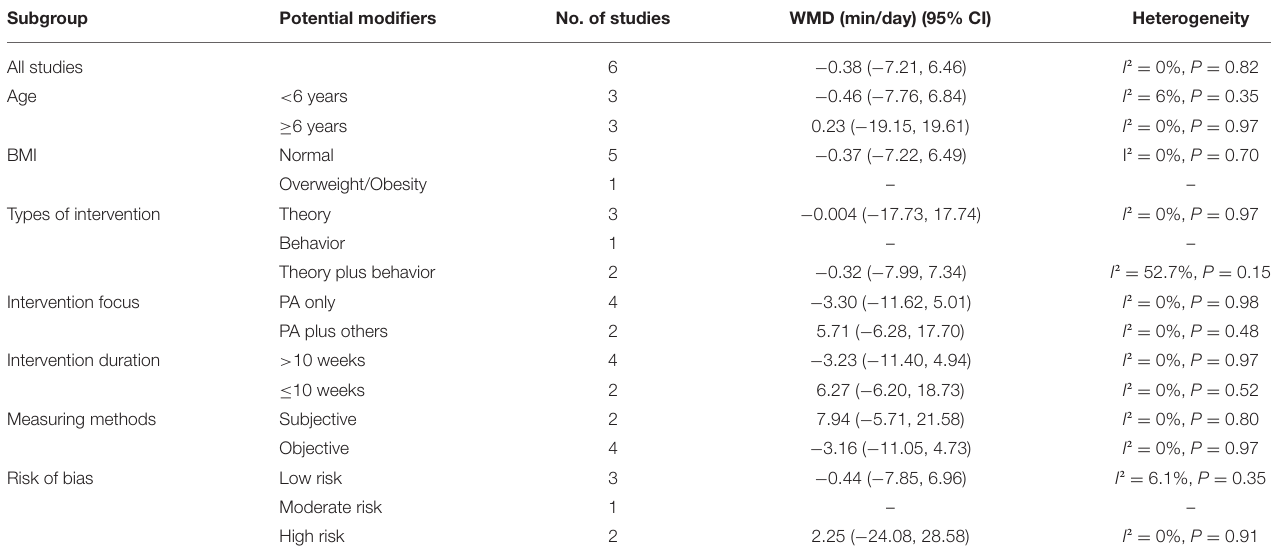
TABLE 3 | Subgroup analysis of the effect of the family intervention on